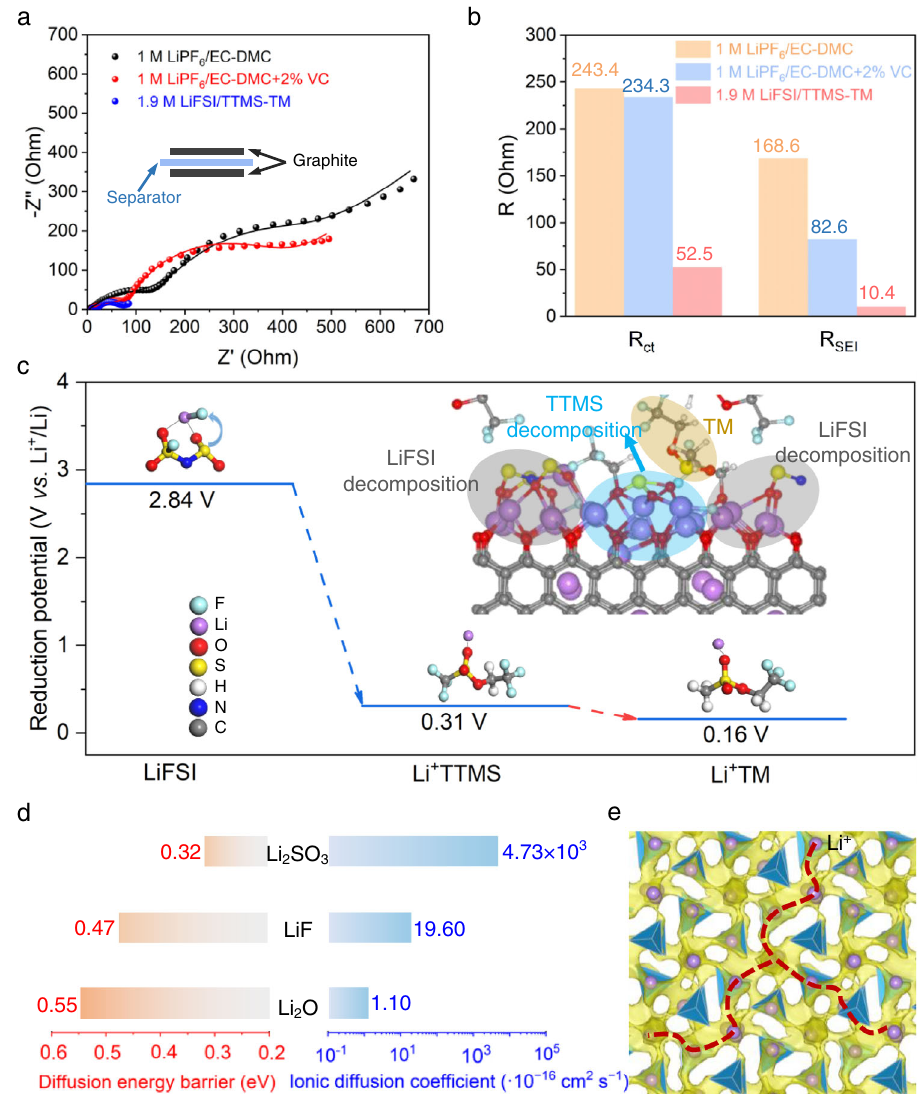
Fig. 5 | Fast kinetics ensured by the 1.9M LiFSI/TTMS – TM electrolyte. a EIS of the symmetric cells using graphite anodes retrieved from the graphite|| NCM811 cells after 1000 cycles in different electrolytes. b The resistance obtained by fi tting with the equivalent circuit shown in Supplementary Fig. 27. c Calculated reduction potentials (vs. Li + /Li) and reduced complexes of LiFSI, TTMS, and TM